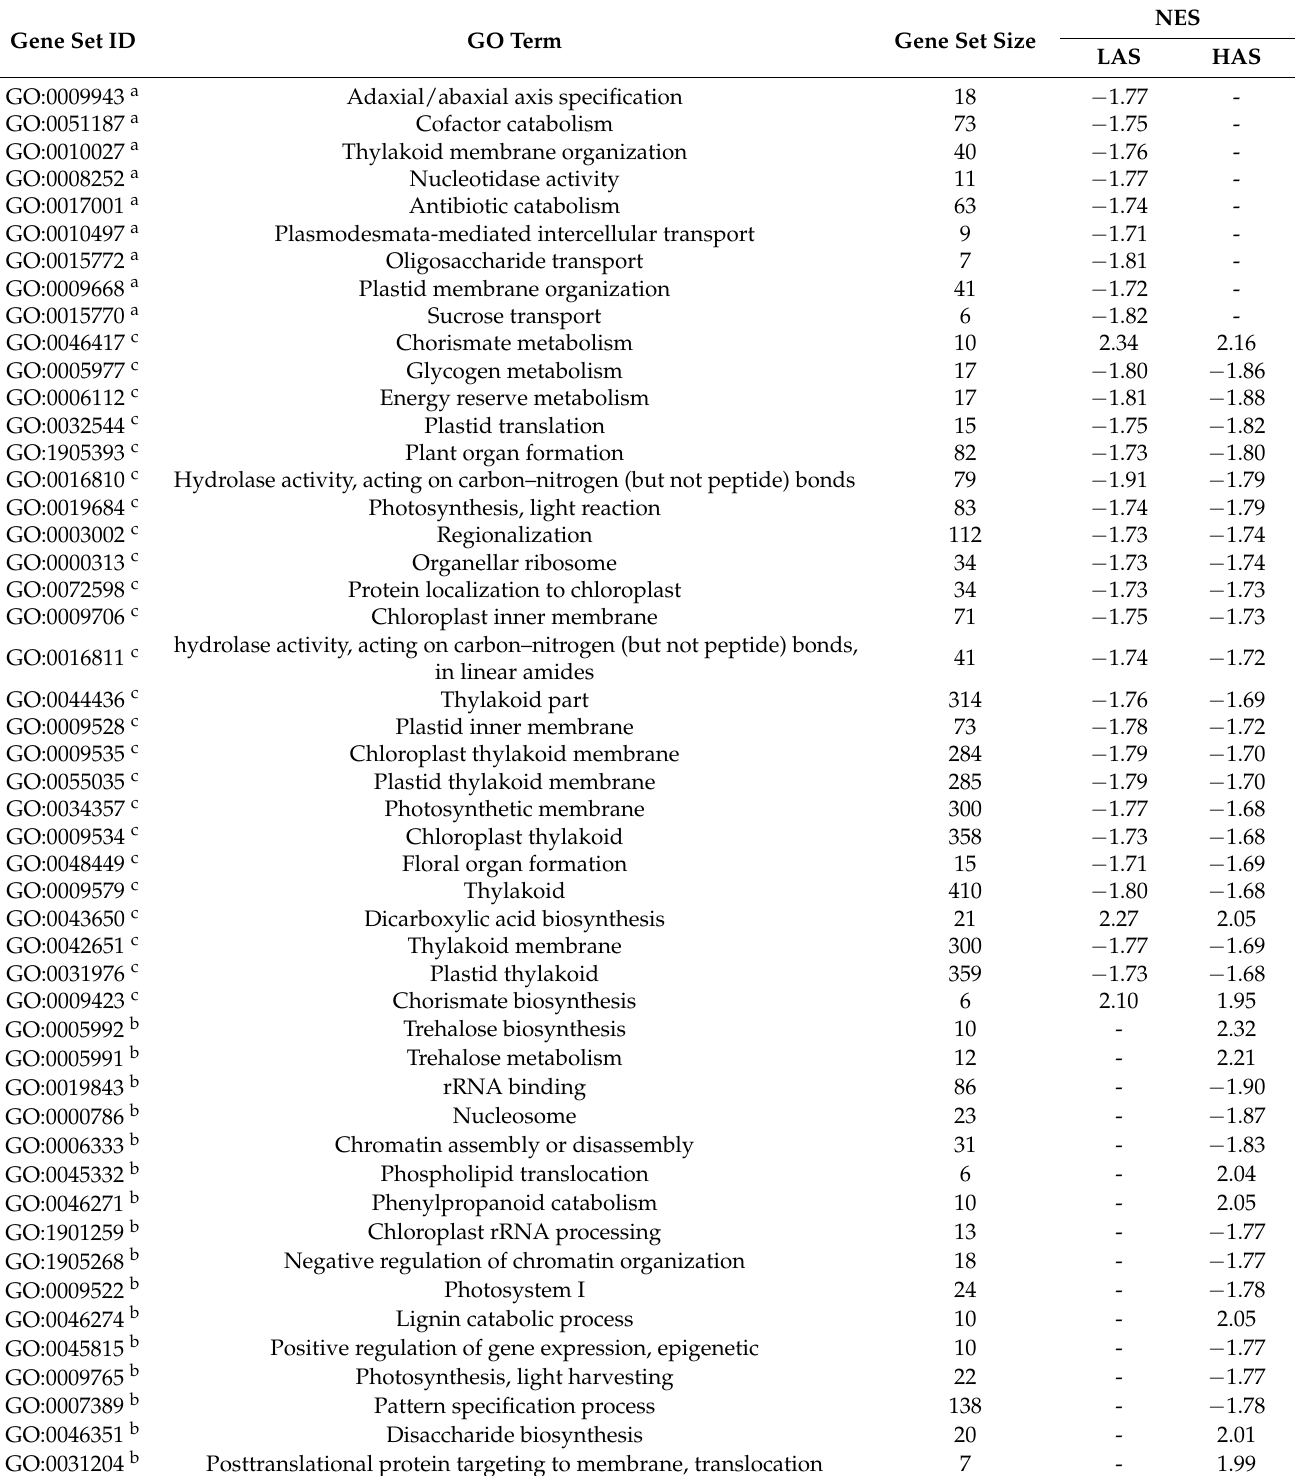
Table 2. Terms of enriched gene sets associated with alkali stress in M. cerifera determined using GSEA. This table shows NES obtained from GSEA for those gene sets with significant enrichment (FDR q-value < 0.20 and NOM p -value < 0.01). The superscripts “a” and “b” represent GO terms significantly enriched in LAS and HAS groups, respectively, while superscript “c” represents GO terms shared by the two treatment